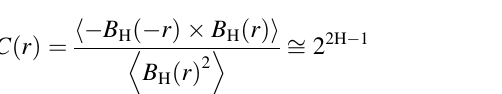
Table 1 Methods of determination of fractal dimensions Method Summary method of fractal dimension (D) Box-counting